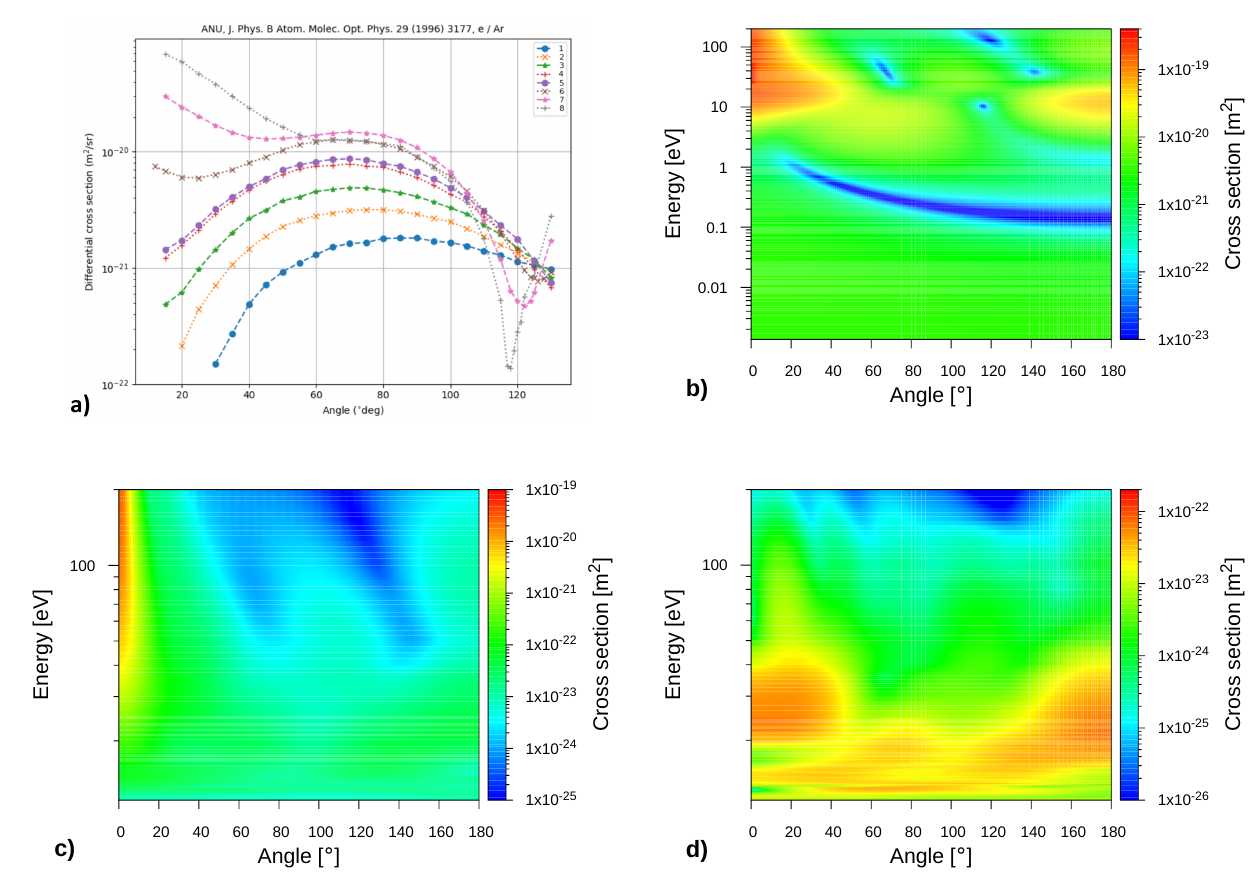
Figure 4. Differential scattering cross-section for elastic and inelastic scattering processes with argon ground state. ( a ) Exper- imental measurement of elastic electron/Ar collisions from ANU database [39,40] for different electron-impact energies with label from 1 to 8: 1 eV, 1.5 eV, 2 eV, 3 eV, 3.14 eV, 5 eV, 7.5 eV and 10 eV; Theoretical calculations from the BSR database [41–43] using the R-matrix method of differential cross-sections for electrons with ground state Ar: ( b ) elastic collision; ( c ) electronic excitation from ground state to Ar ∗ 4 s (cid:48) [ 1/2 ] 1 state; ( d ) electronic excitation from ground state to Ar ∗ 4 s [ 3/2 ] 2